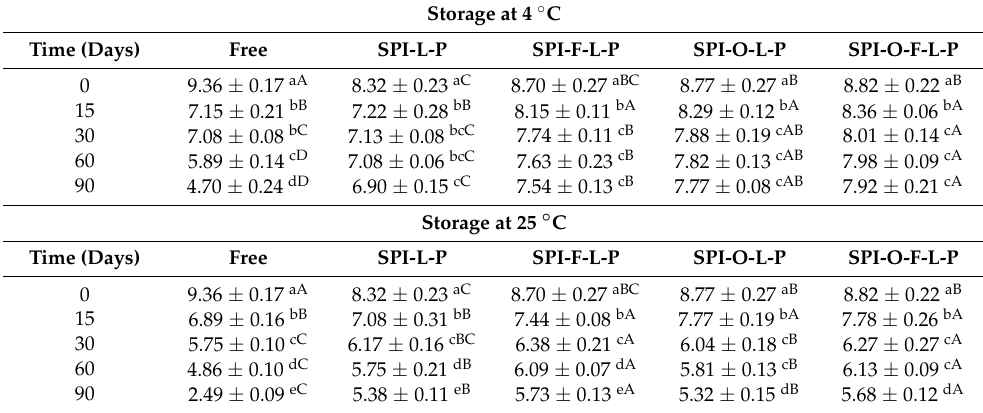
Table 1. The viability of probiotics encapsulated in different microcapsules during